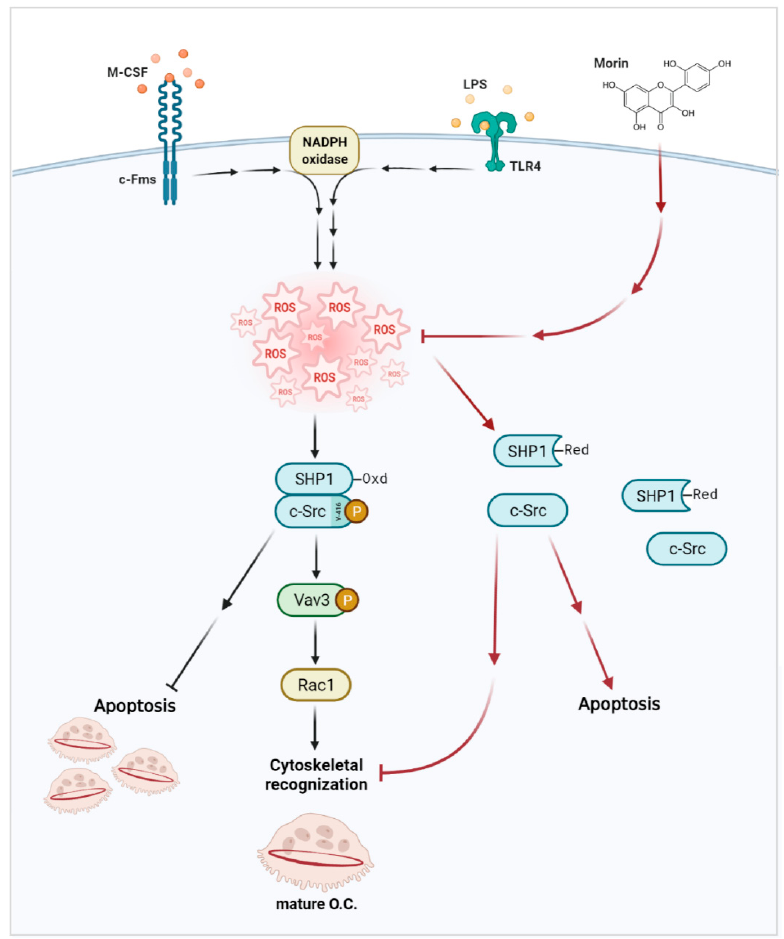
Figure 6. Morin decreases the number and area of OCs. LPS increased number of OCs by inhibiting apoptosis, as well as OC activity by enhancing cytoskeletal reorganization. Morin reversed both via an ROS/SHP1/c-Src